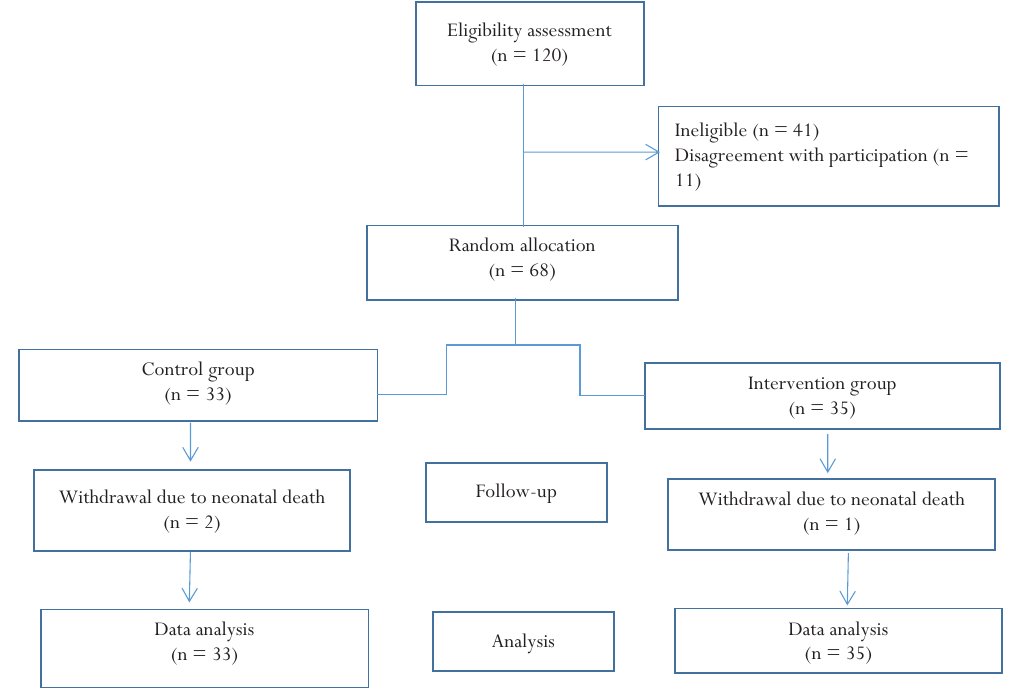
Figure 1. The flow diagram of the